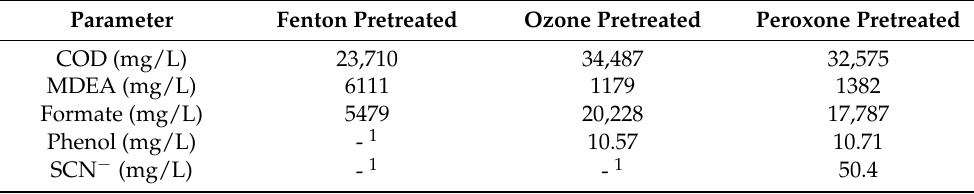
Table 2. Characteristics of AOP-pretreated reclaimer